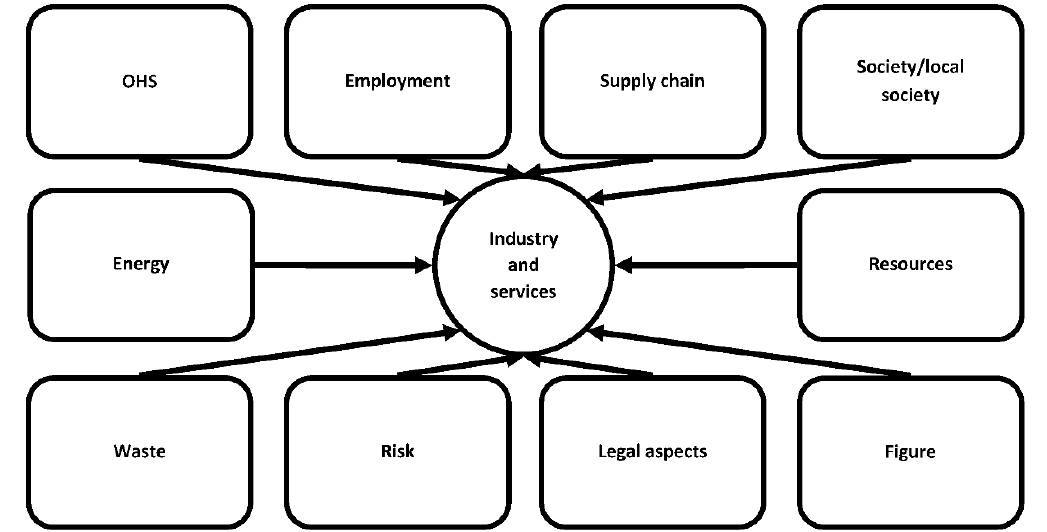
Figure 2. Key aspects of sustainability in organizations. Source: Own study based on, Holton I., Glassb J., Priceb A., Managing for sustainability: findings from four company case studies in the UK precast concrete industry, Journal of Cleaner Production , Volume 18, Issue 2, January 2010, pp. 152–160.